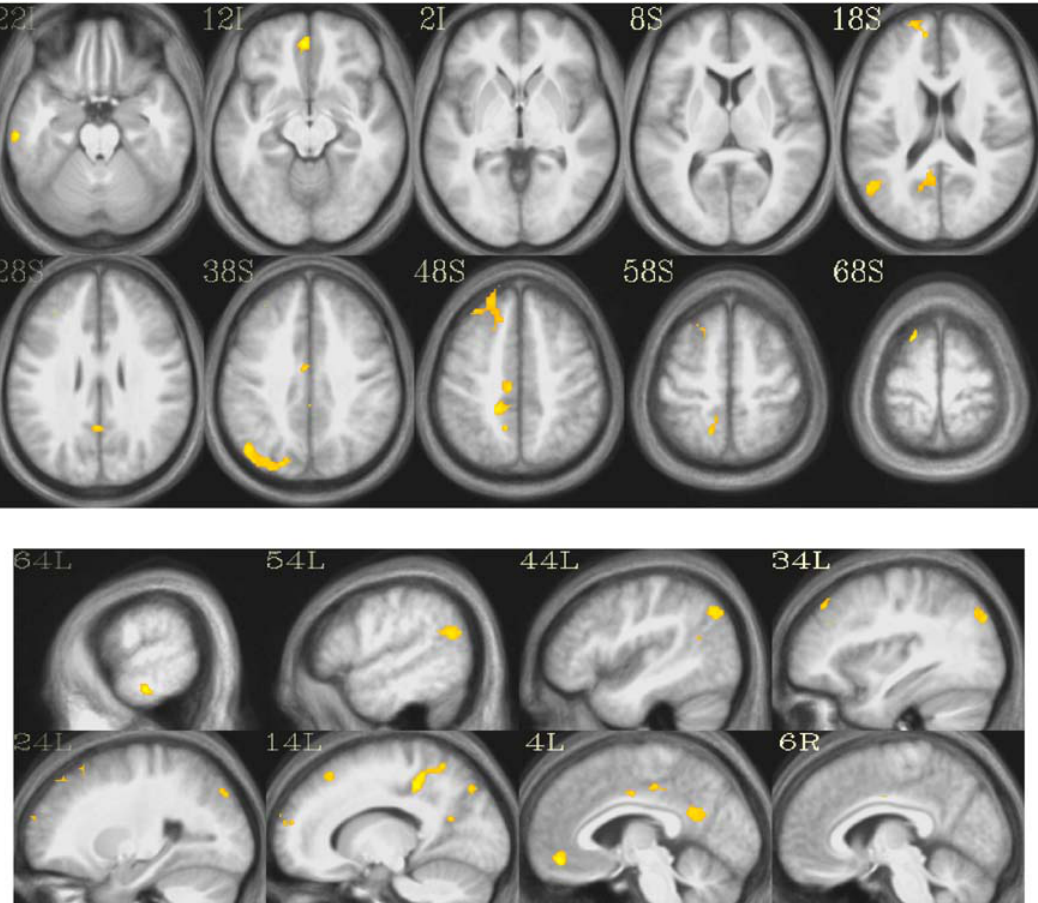
Figure 1. Activated clusters for the contrast words-nonwords on the pooled data (CTRL + MEDT). The t -map is thresholded at p , 0.001, k . 27 voxels ( a , 0.05).